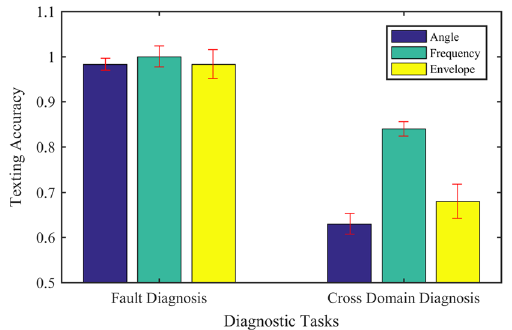
Figure 15. Diagnostic performance of different input methods.